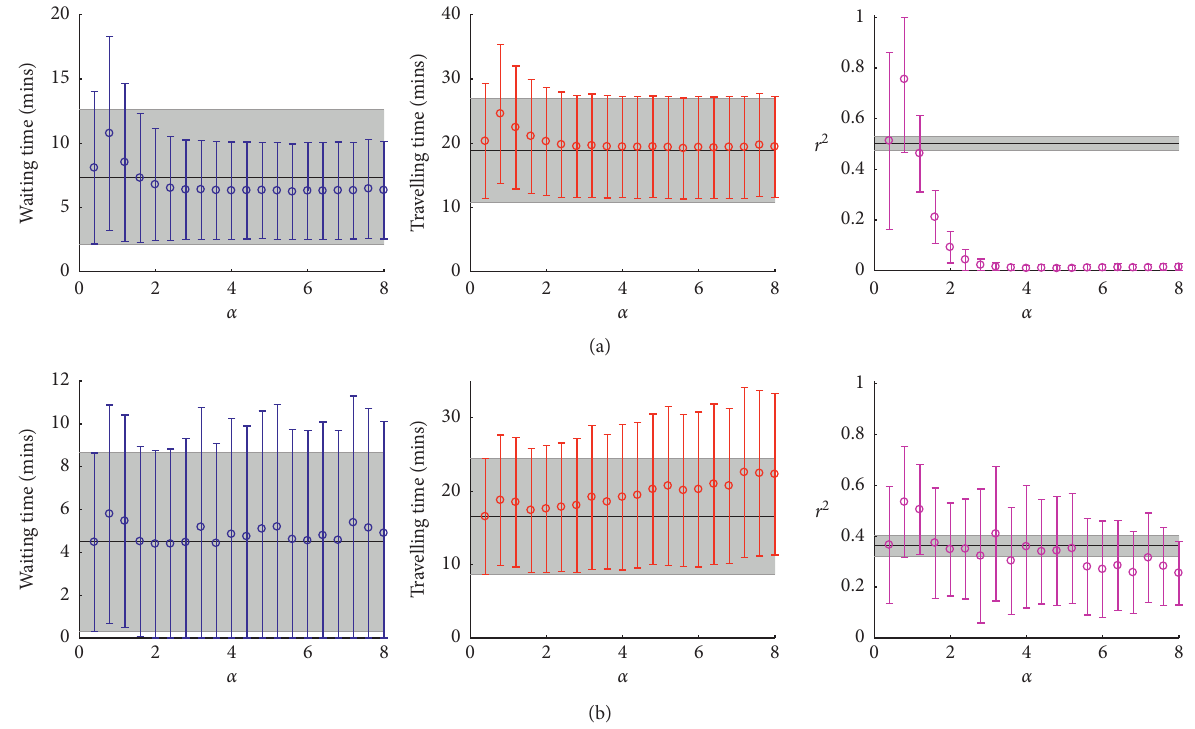
Figure 12: Results of the c-holding strategy in the two different-velocity scenarios. Each colored point represents the mean and standard deviation of the measured quantities calculated from 100 realizations of each parameter value. The black line and grey shaded area of each graph denote the mean and standard deviation of the measured quantities from a control case, which are simulation runs of the same parameter values, without any intervention strategies. (a) C-holding strategy in lull-different. (b) C-holding strategy in